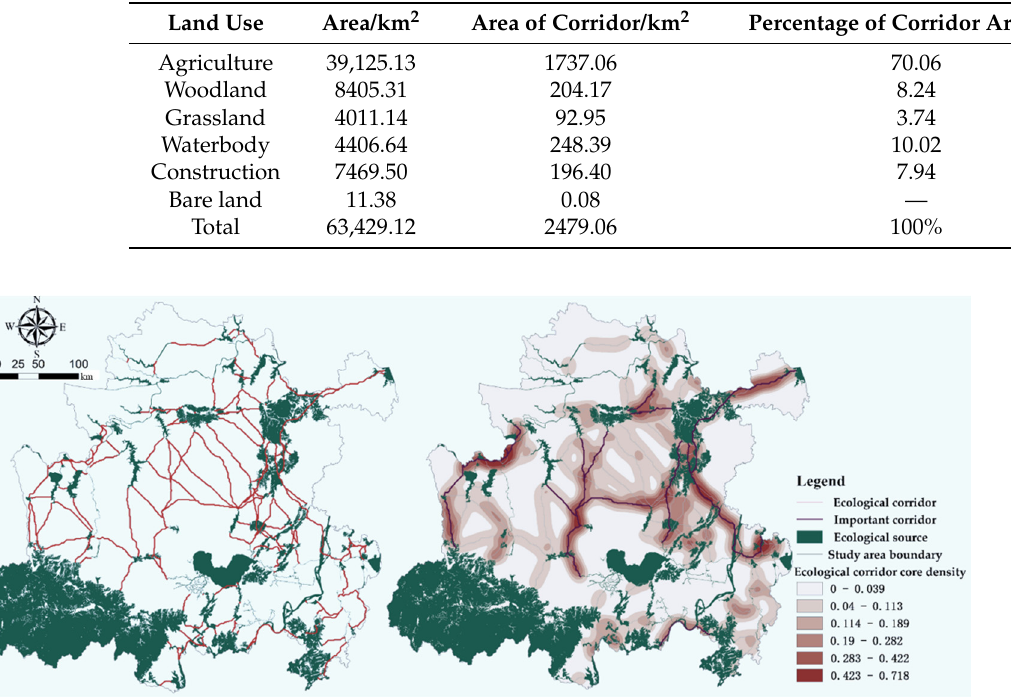
Figure 7. Ecological corridor map of Hefei Metropolitan Area. Table 4. Landscape composition of an ecological corridor.